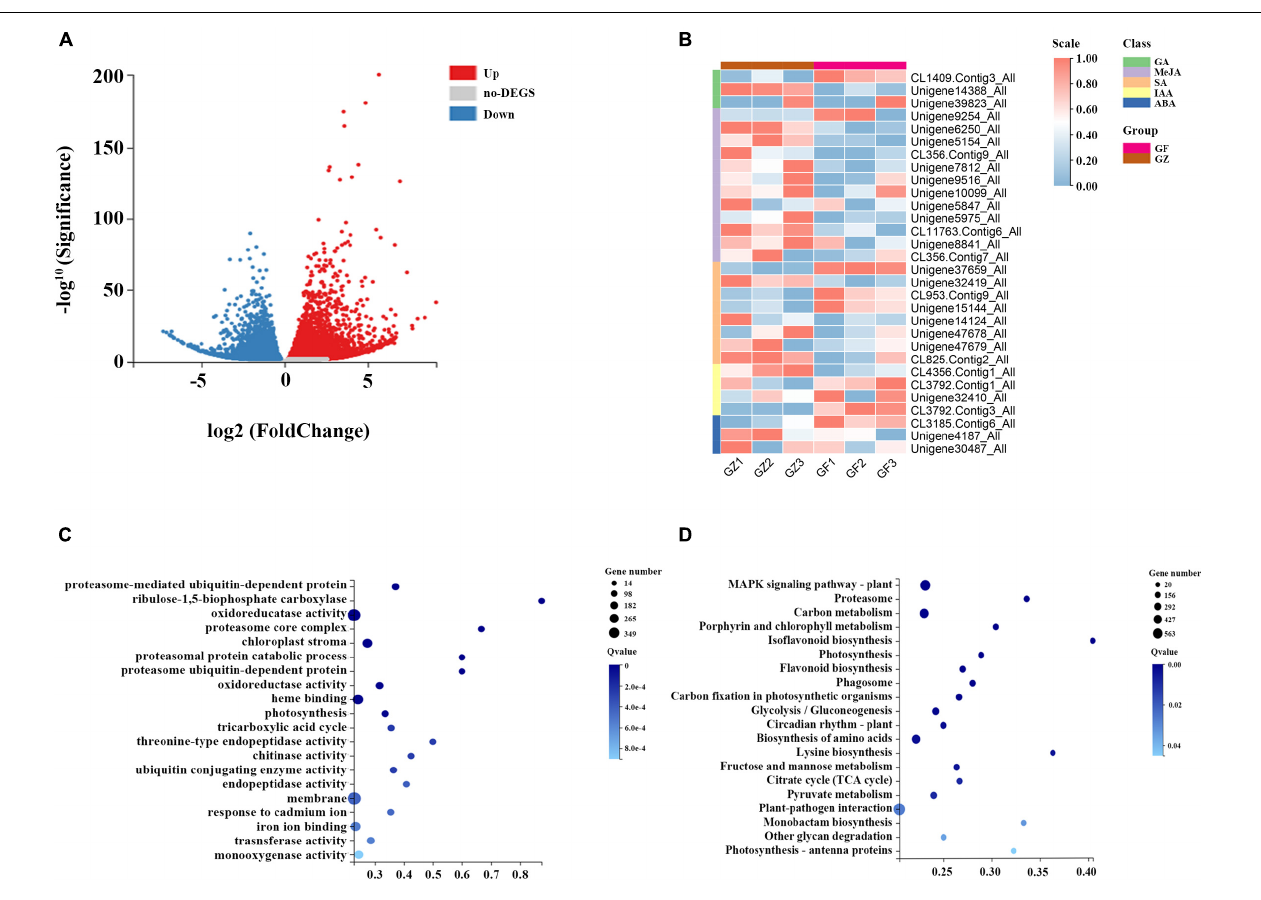
FIGURE 3 | (A) Volcano plot of differential gene expression analysis. (B) Heatmap of hormone-related genes expression level. (C) Gene Ontology (GO) level terms classification of differential genes. (D) Kyoto Encyclopedia of Genes and Genomes (KEGG) pathway analysis for differential gene expression analysis between GZ and GF in T. hemsleyanum